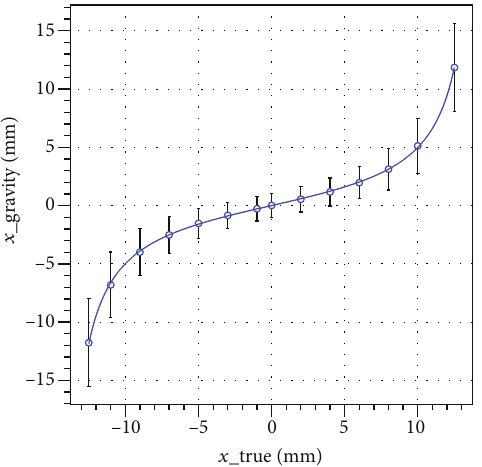
Figure 2: The x position versus the x gravity electrons. The solid blue line is the S-like